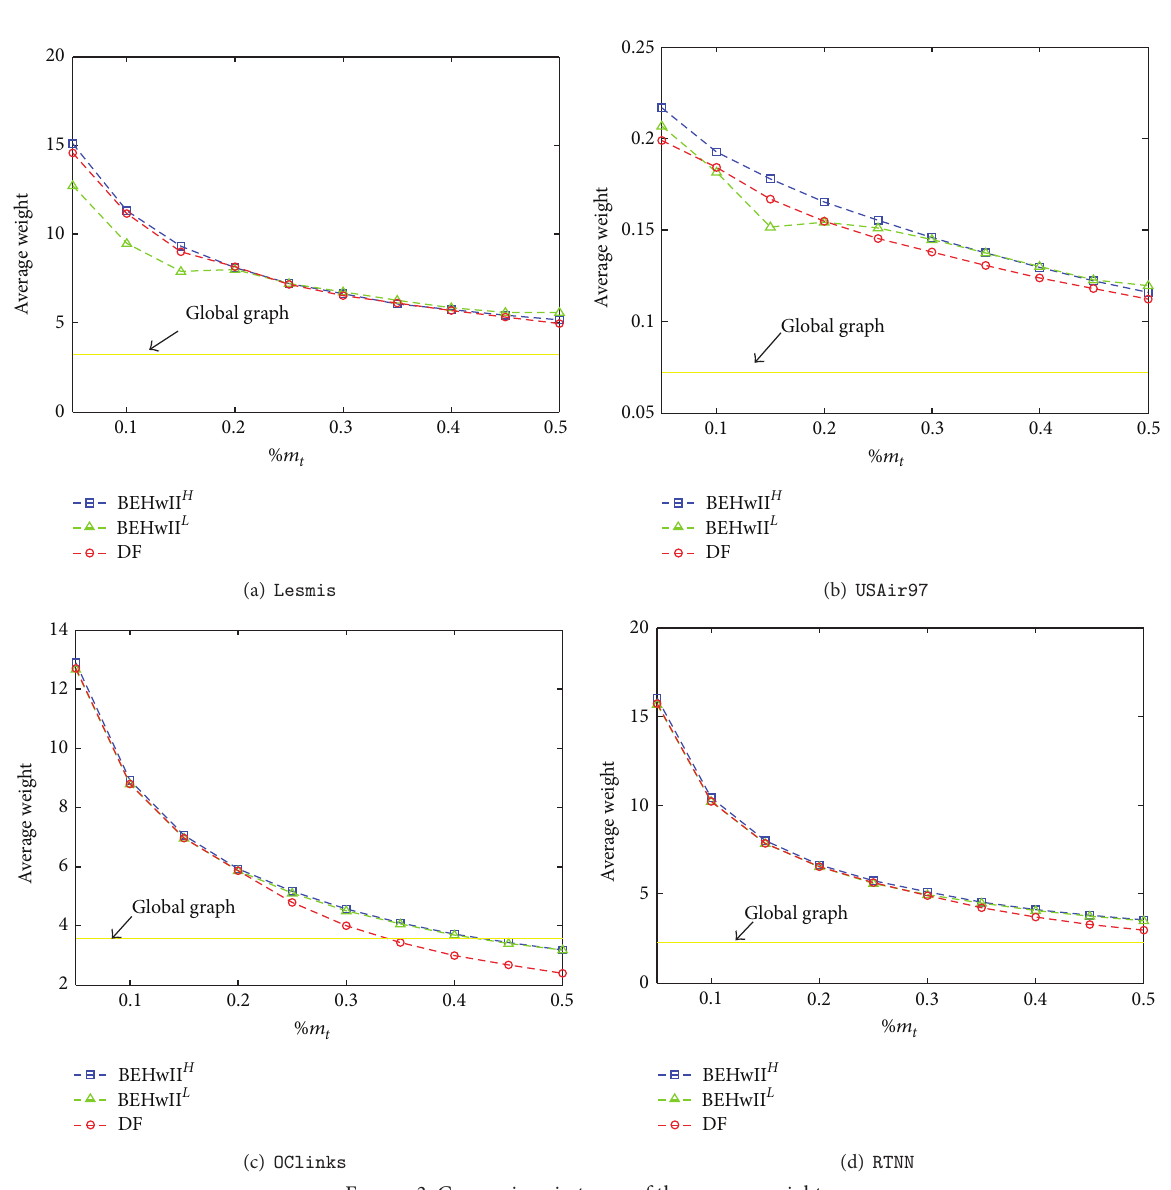
Figure 3: Comparison in terms of the average weight. Table 1: Real-world networks for